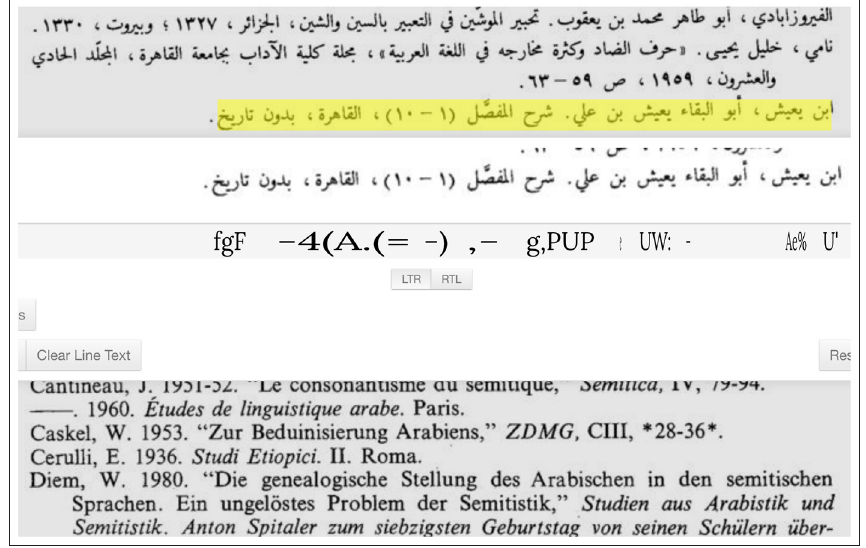
Figure 26: Page with substantial Non-Arabic language interferes with Arabic OCR.